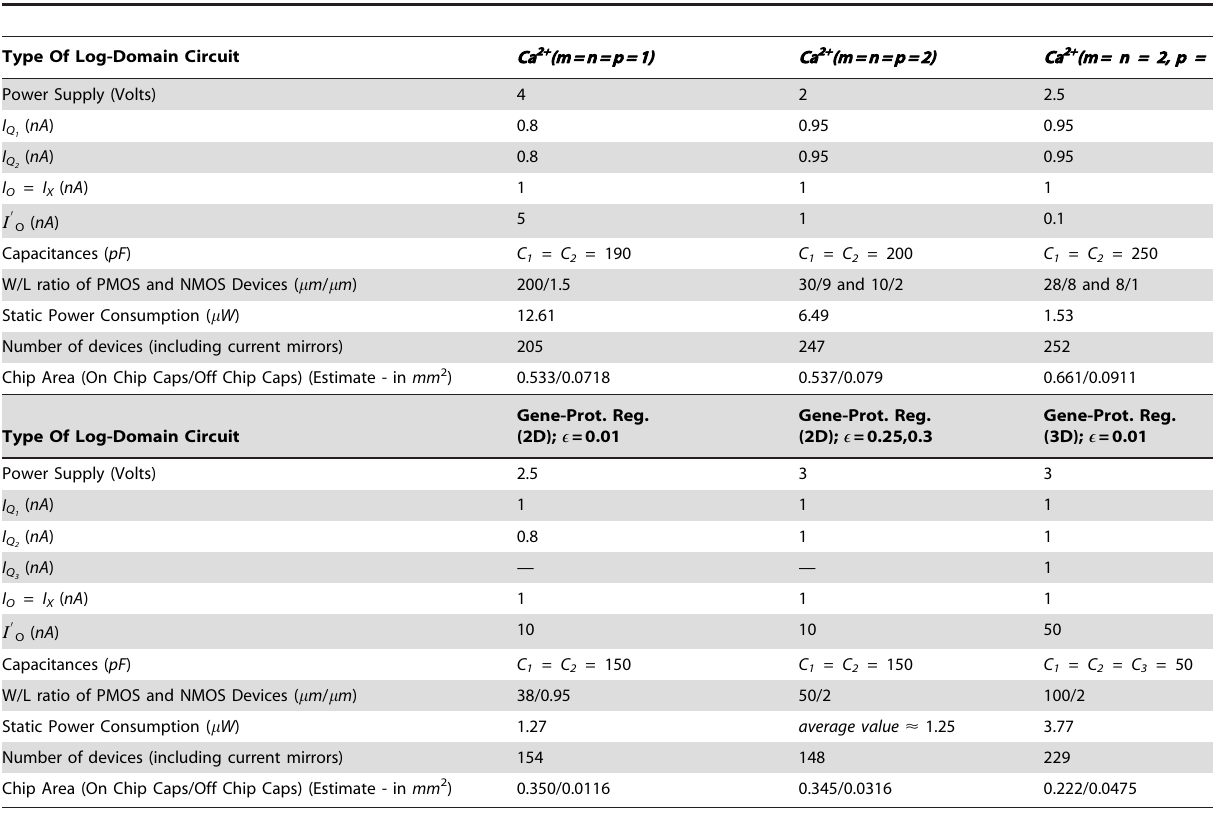
Table 9. Electrical Properties Of Log-Domain Intracellular Ca 2 + Oscillations & Gene-Protein Regulatory Circuits.